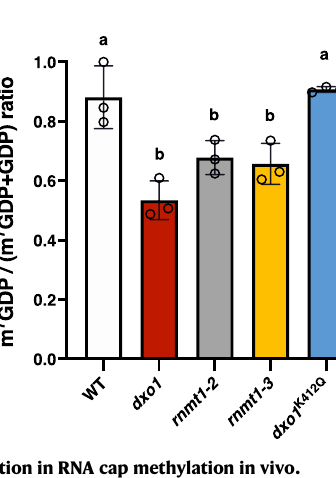
mean±SD ( n =3 biologically independent samples). b Dot blotting analysis for detection of m 7 G-mRNAs. The mRNA samples were spotted onto the nylon mem- brane and probed with the m 7 G antibodies. For the negative control, mRNAs were decapped with the mRNA Decapping Enzyme before being spotted onto the membrane. Different concentration of m 7 GpppG was spotted to the membrane as standards. b represents the results from one of three independently performed experiments with similar